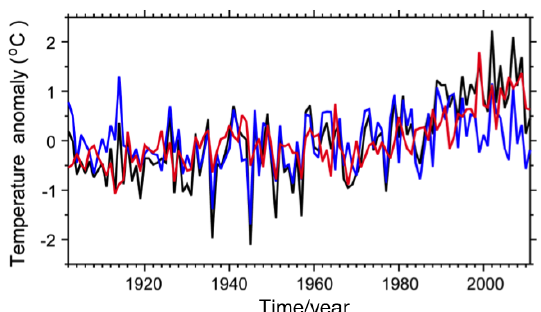
Figure 2. Time series of regionally averaged temperature anomalies of raw (black), dynamically induced (blue), and radiatively forced (red) temperatures in the cold season (November to March) from 1902 to 2011 over east Asia.